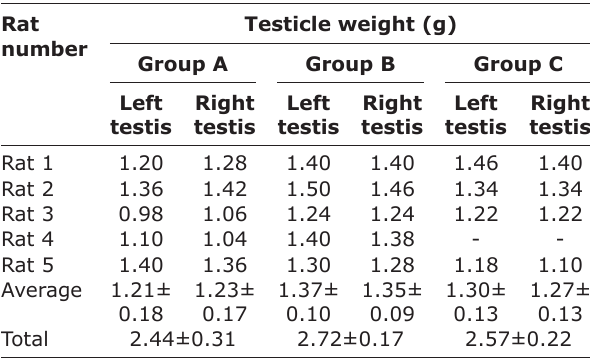
Table-3: Testicle weight of rats in Group A, Group B, and Group C.